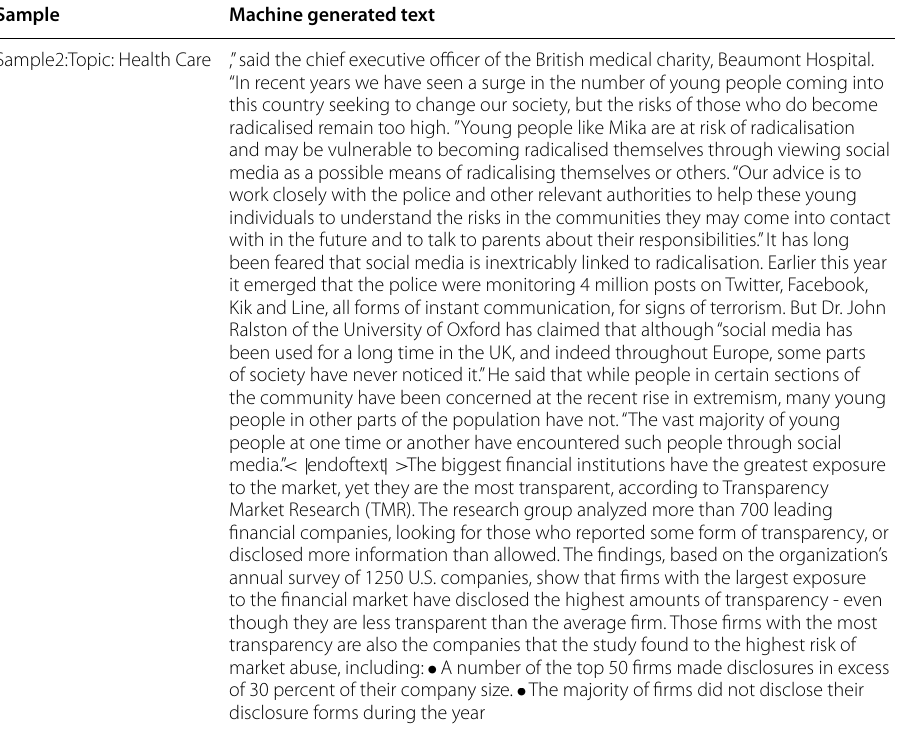
Table 8 Results of non-conditional samples Sample Machine generated